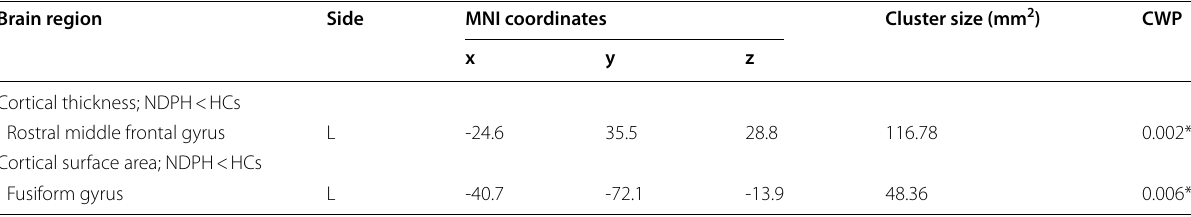
Table 2 Brain region with cortical thickness and surface area changes in patients with NDPH